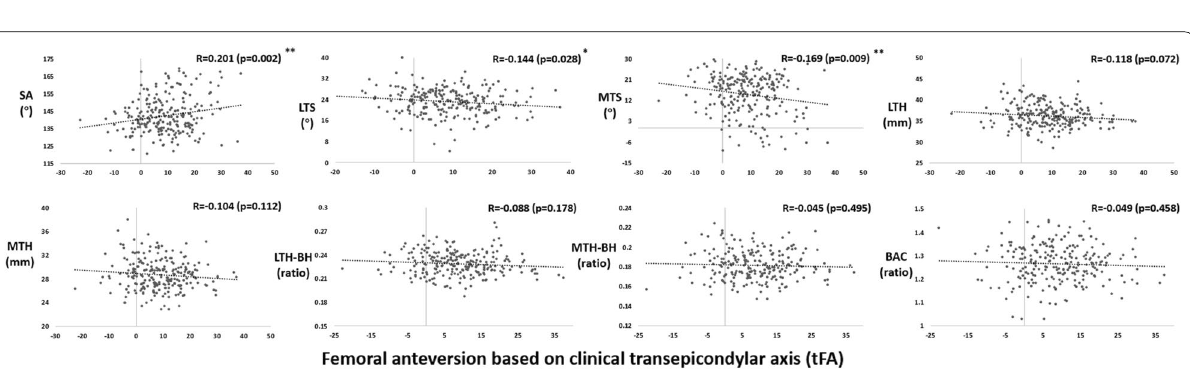
Fig. 6 Correlations of tFA with the morphology of the femoral trochlea, including the sulcus angle (SA), lateral trochlea slope (LTS), medial trochlea height (MTH), medial trochlea height (LTH), medial trochlea height (MTH), lateral trochlea height relative to body height (LTH-BH), medial trochlea height relative to body height (MTH-BH), and bianterior condyle ratio (BAC). * p < 0.05; ** p <